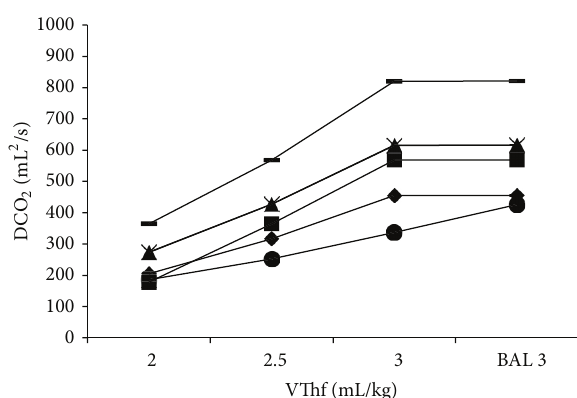
Figure 2: Carbon dioxide diffusion coefficient (DCO 2 ) calculated at different VThf before and after surfactant depletion by bronchoalve- olar lavage (BAL). DCO 2 : carbon dioxide diffusion coefficient calculated as 𝑉𝑡 2 × 𝑓 𝑅 (mL 2 /sec).